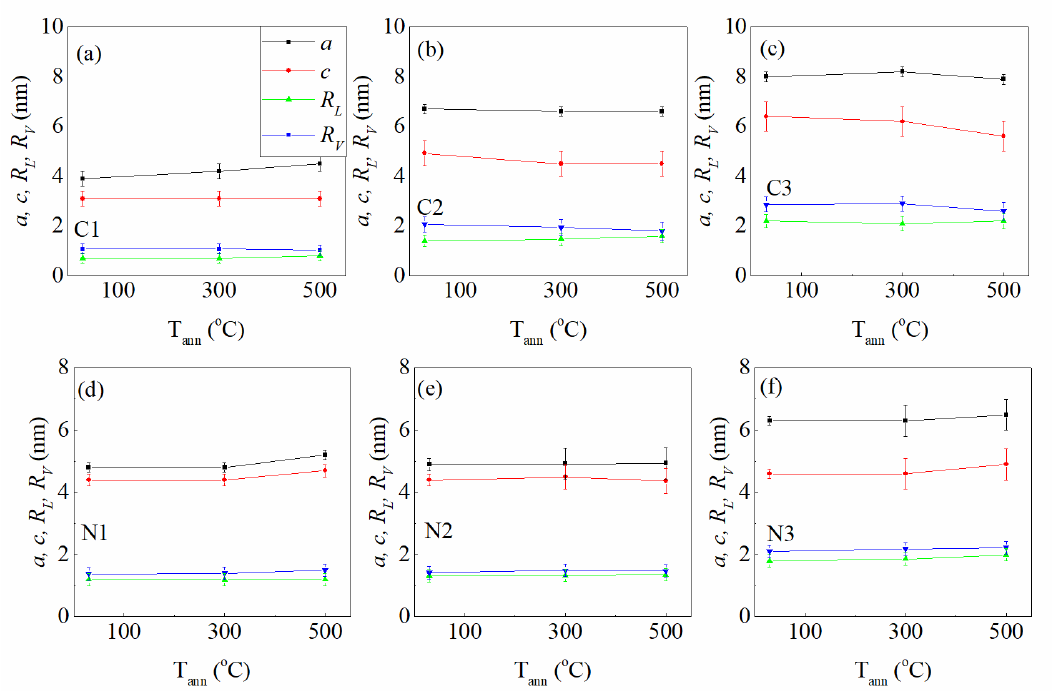
Figure 2. Dependence of the Au NP separations ( a -lateral and c -vertical), and their effective radii ( R L and R V ) on the annealing temperature ( T ann ) for ( a – c ) SiC matrix and ( d – f ) Si 3 N 4